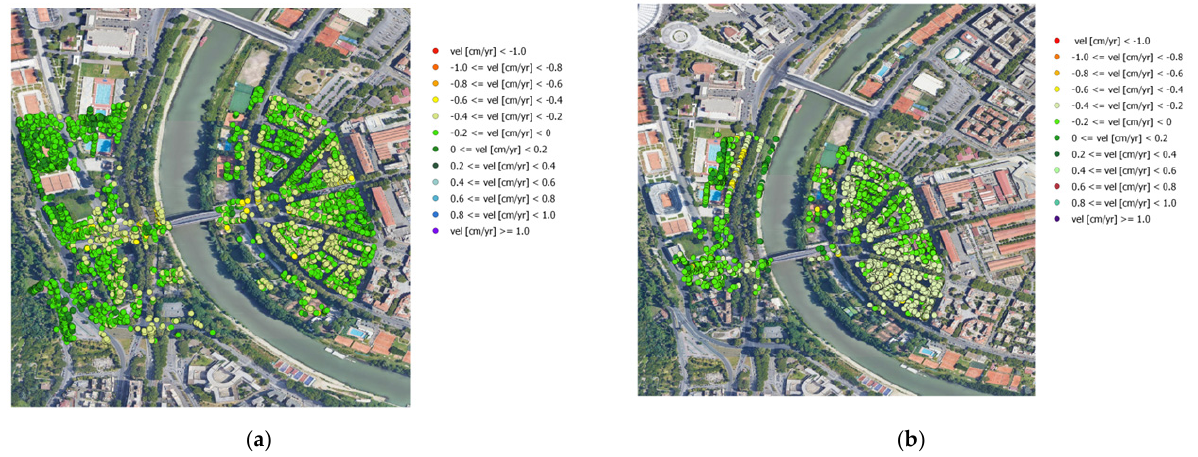
Figure 6. False colors mean deformation velocity maps over the study area: ( a ) ascending and ( b ) descending orbits.